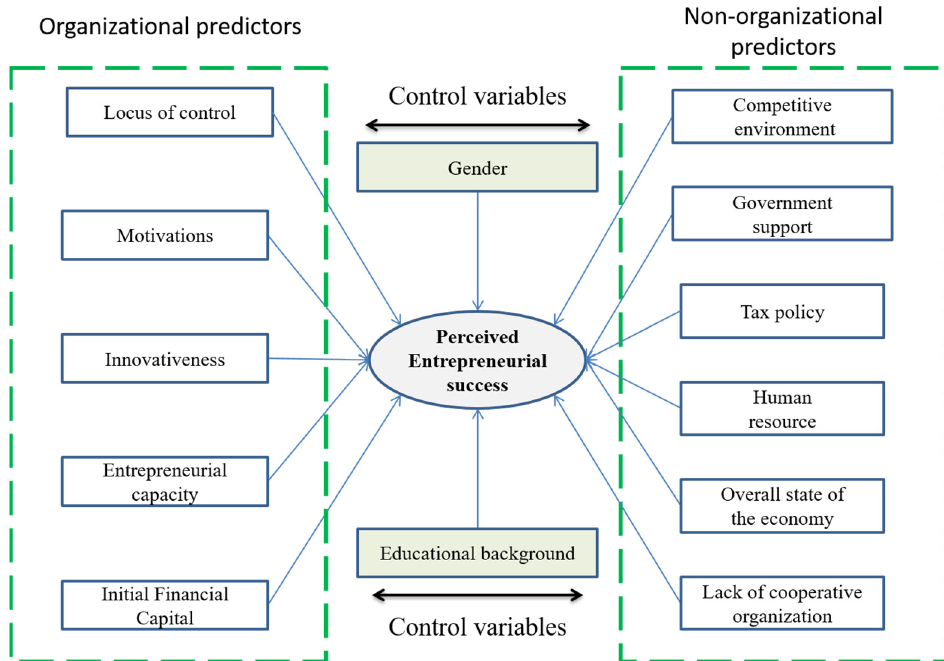
Figure 2. The research framework of study. Source: processed by researchers .